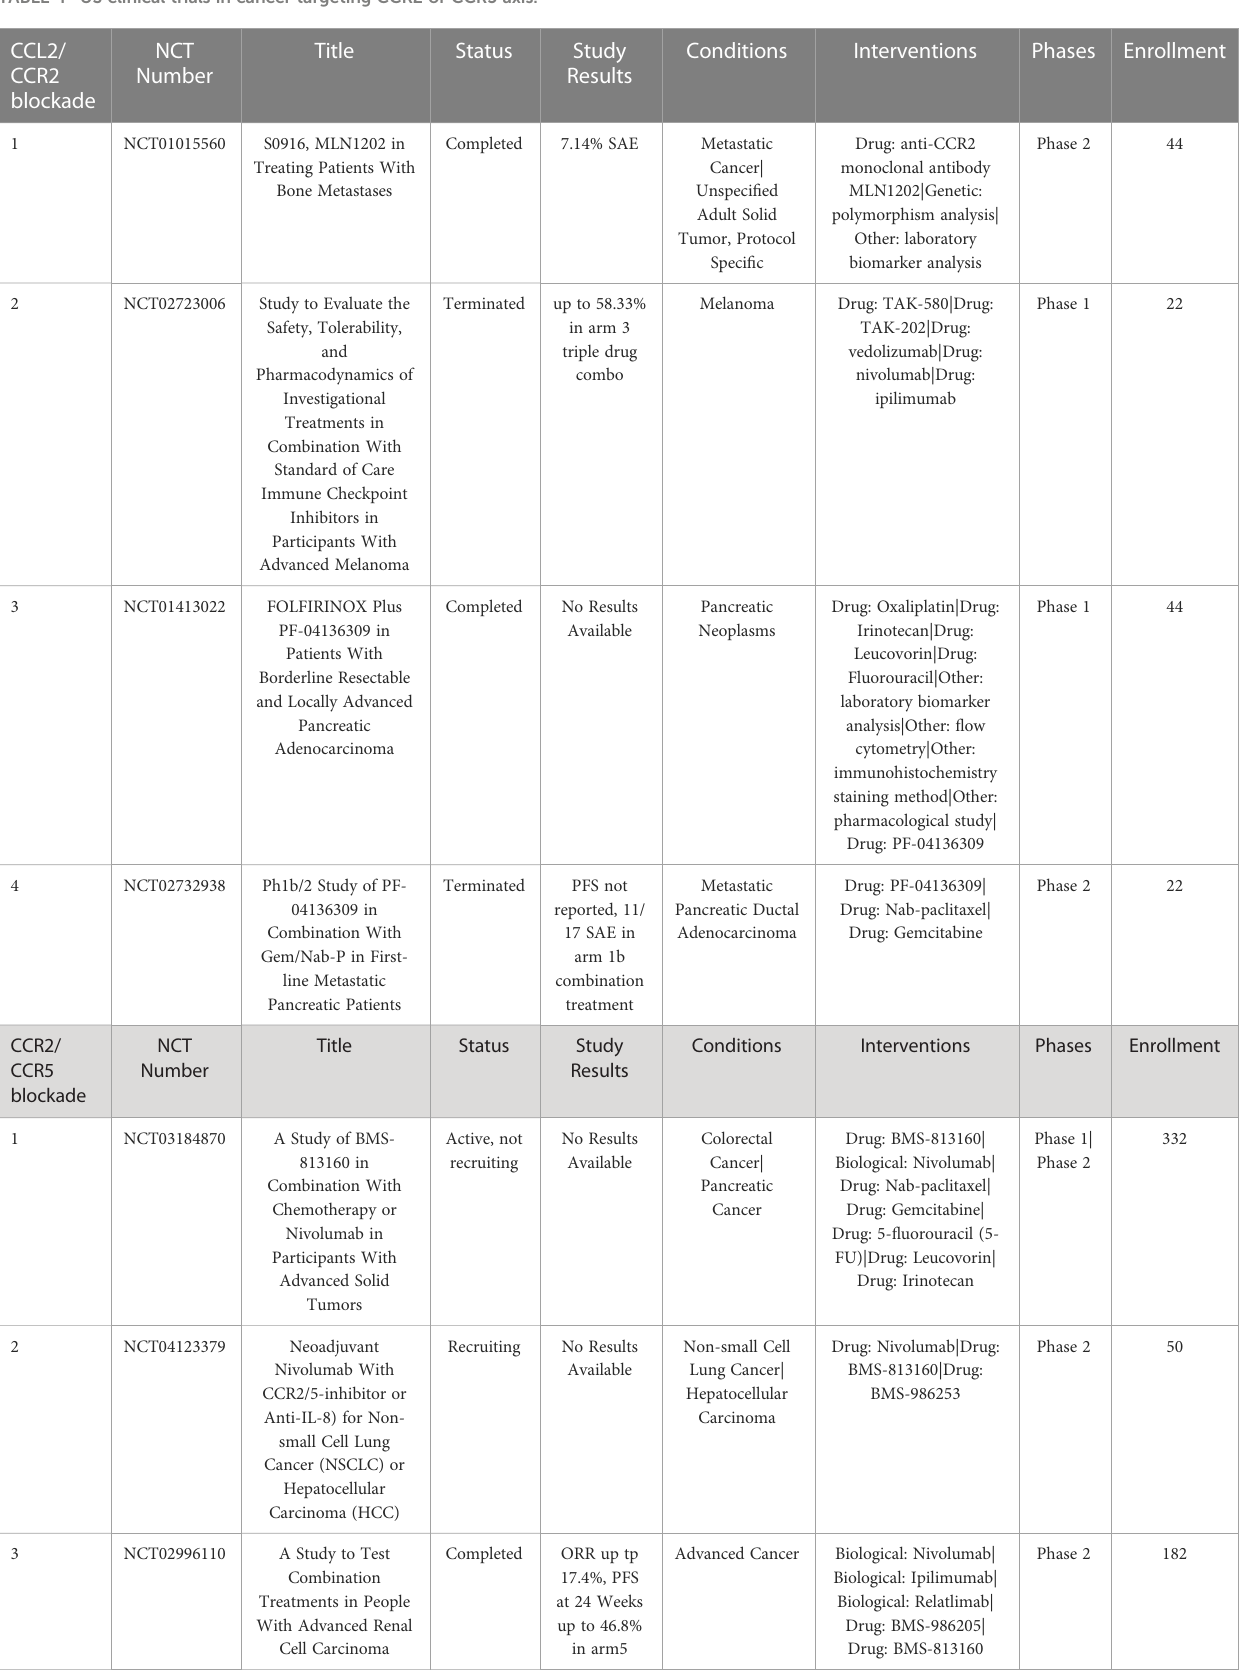
TABLE 4 US clinical trials in cancer targeting CCR2 or CCR5 axis. CCL2/